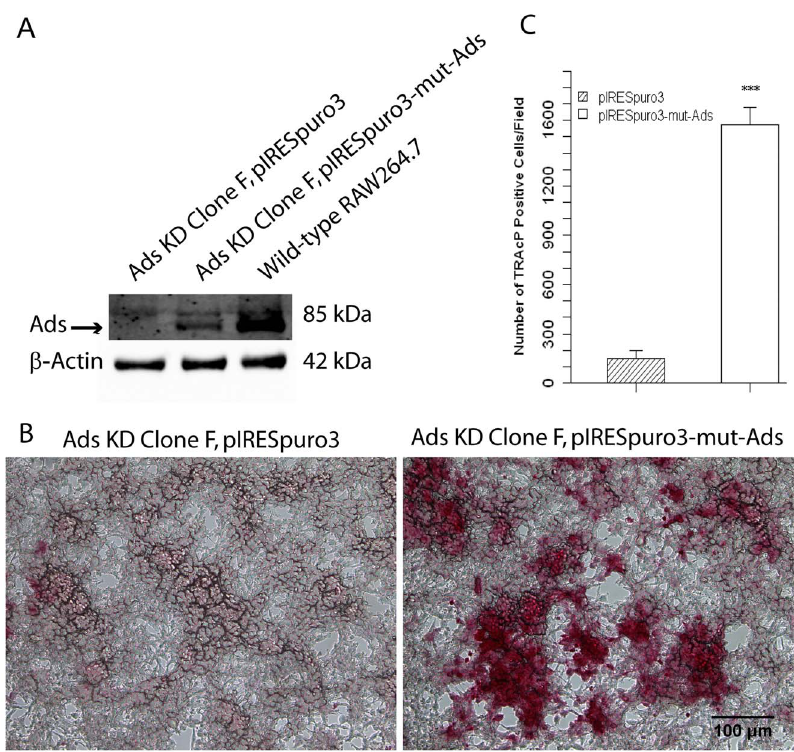
Figure 10. Adseverin knockdown cell-rescue restores pre-osteoclast differentiation. Two million Ads KD Clone F cells were transiently transfected with 2 m g of pIRESpuro3-mut-ads. The construct was constructed using site-directed mutagenesis such that the shRNA targeted sequence was mutated without changing the final protein product. A control transfection with an empty vector pIRES-puro3 was also carried out. A ) Ads was not detected in the control transfection. Following transfection, Ads protein levels were increased to 22% of WT levels. B & C ) The slight transient increase in Ads protein expression resulted in significantly more mononuclear, TRAcP positive ells. This phenotype was not found in the control transfection